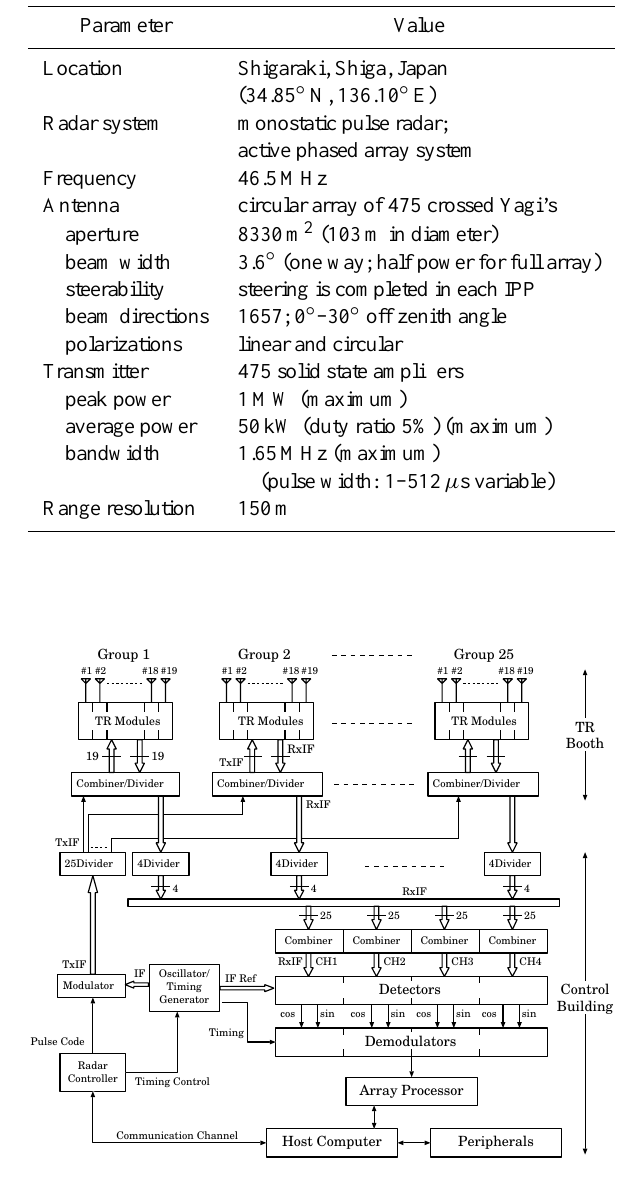
Fig. 2. Receiver and signal processing system at the MU